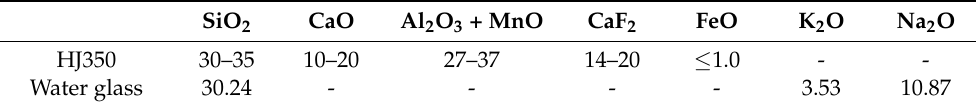
Table 1. Chemical composition of HJ350 and water glass.